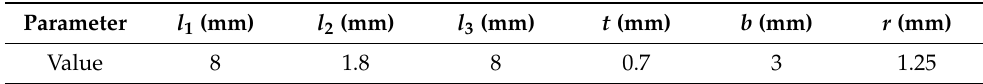
Table 1. Main parameter of the Z-shaped flexure